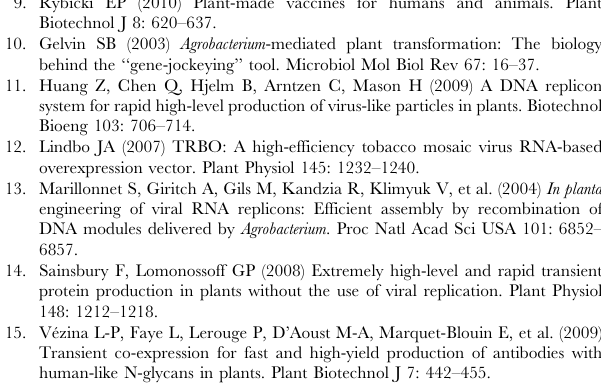
Figure S1 Activity levels of C5-1 along the leaf age gradient. Relative C5-1 activities in protein extracts from leaves transiently expressing the antibody alone or along with Sl CYS8 or Sl CDI were estimated by ELISA, on a total soluble protein basis. Absorbance values for C5-1 alone in each leaf were given an arbitrary value of 1 (dashed line); values with co-expressed Sl CYS8 or Sl CDI are presented, normalised for each leaf. Each bar is the mean of three independent (biological replicate) values 6 SE. Asterisks (*) indicate significant differences compared to C5-1 alone (ANOVA, P , 0.05). Table S1 Proteolytic activities (units/s) in whole-leaf and apoplastic extracts of N. benthamiana leaves either uninfiltrated or six days after infiltration with Agrobac- teria containing an empty vector or a C5-1 expression